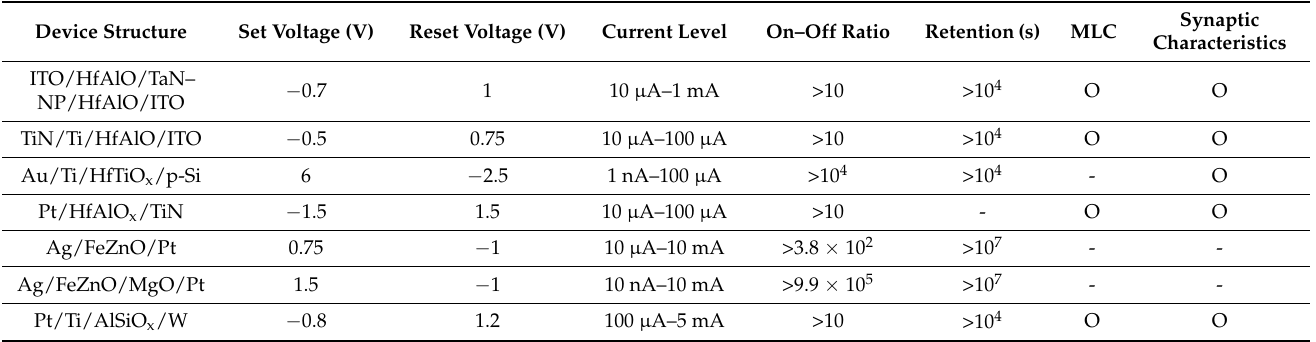
Table 1. Comparison of alloyed and bilayer type RRAM in terms of memory device